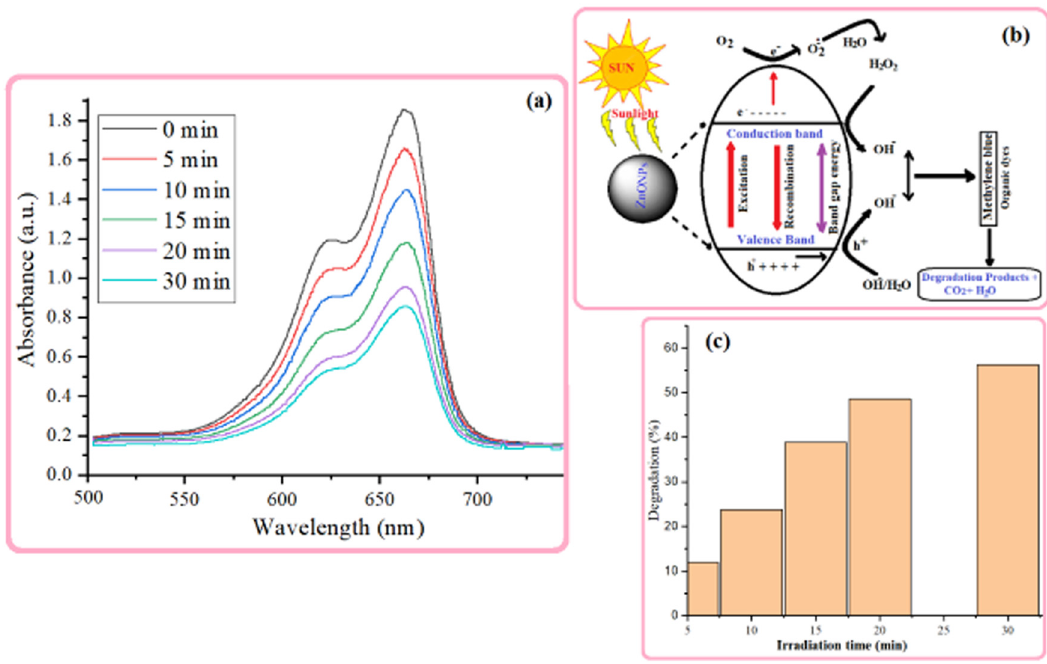
Figure 8: ( a ) Photocatalytic degradation of methylene blue using biogenic ZnO NPs, ( b ) photo trigger mechanism of ZnO NPs in dye degradation in direct sunlight and ( c ) degradation e ffi